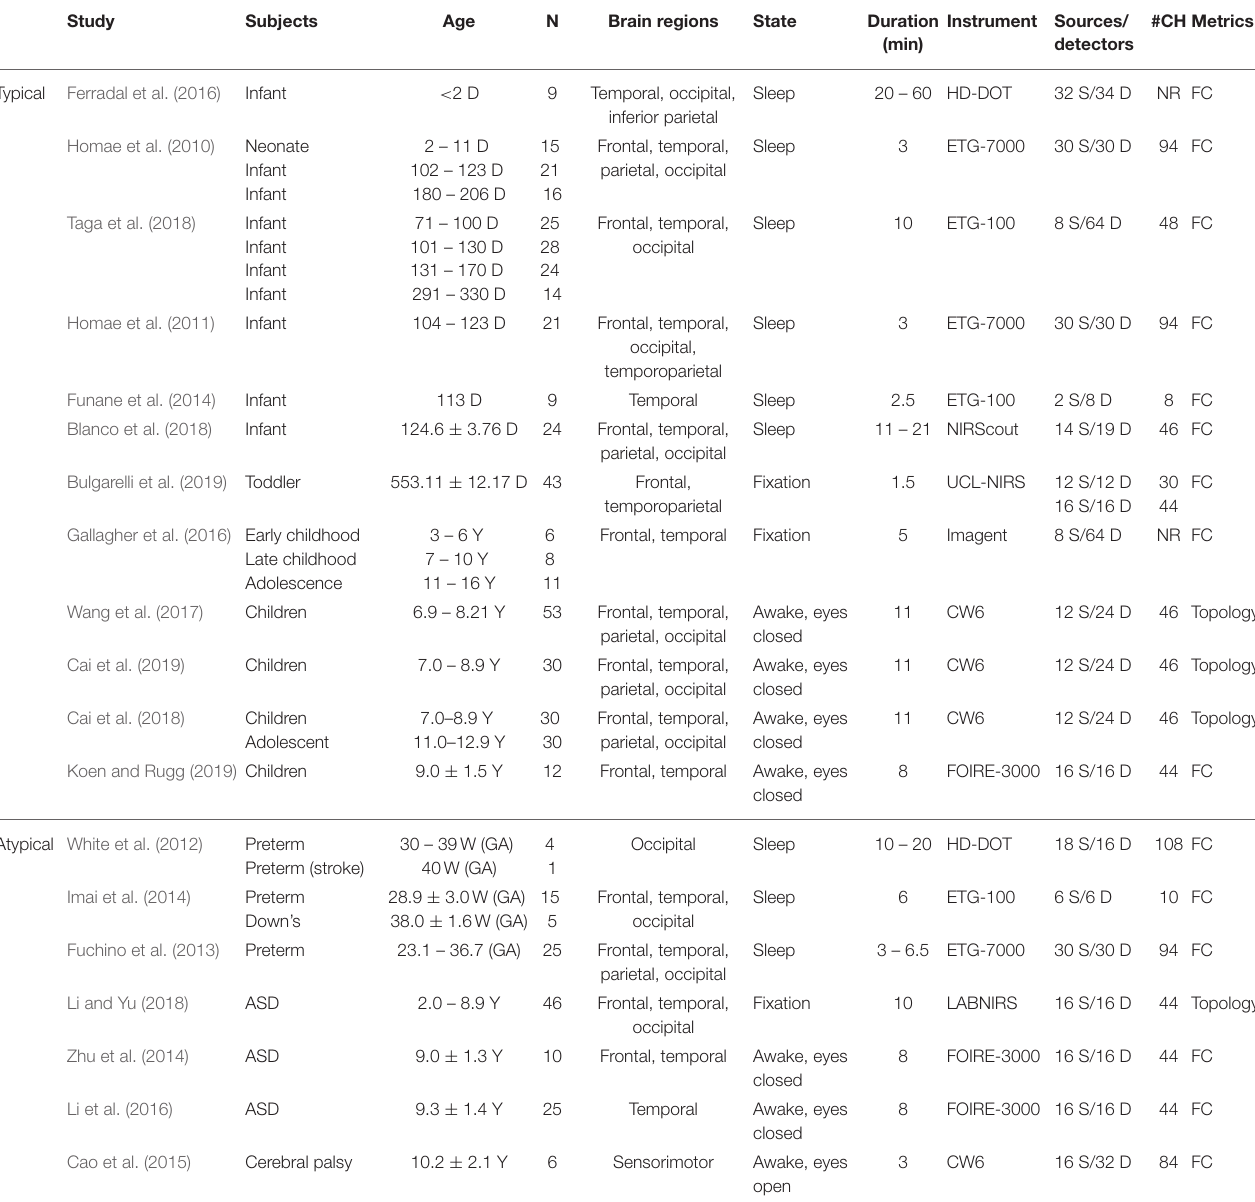
TABLE 1 | Overview of the included